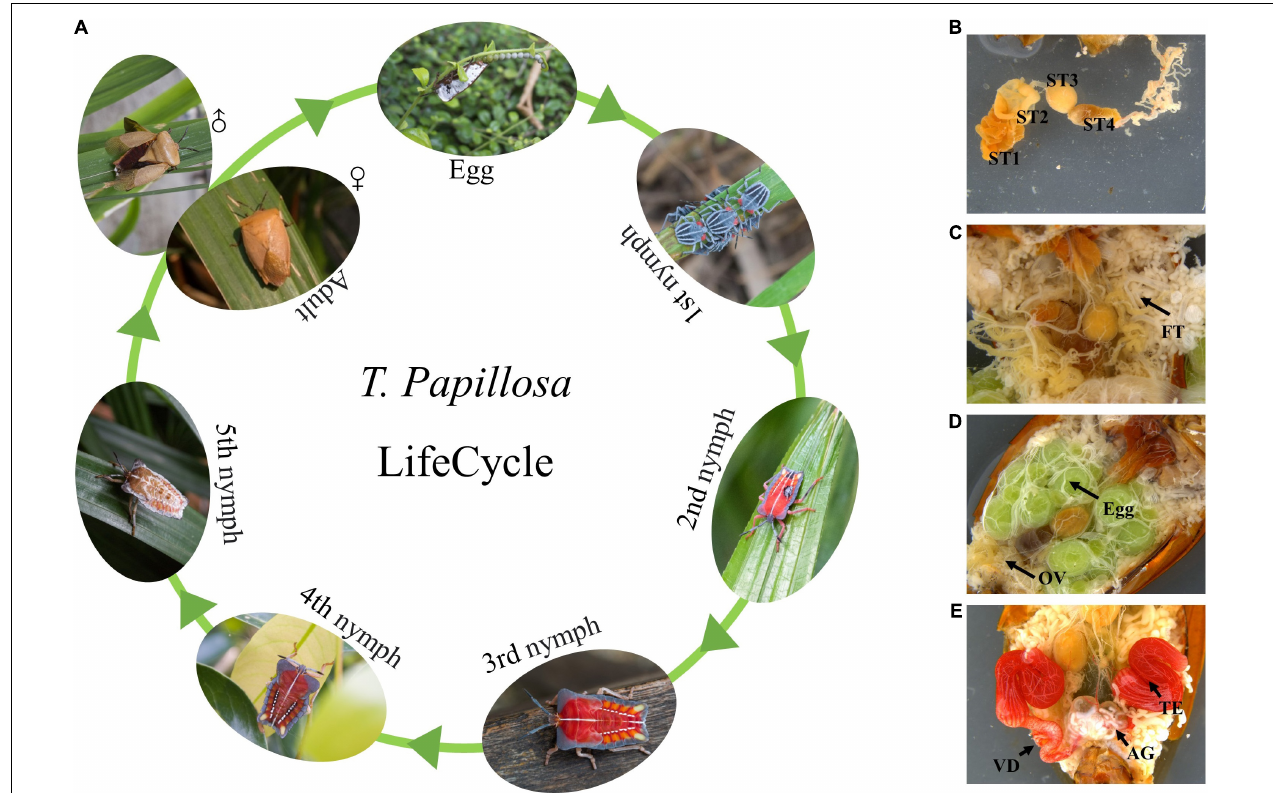
FIGURE 1 | Morphology of T. papillosa at different developmental stages and organization Chart. (A) T. papillosa Life cycle. (B) reproductive system of female adult. (C) Digestive tract. (D) Internal organs. (E) reproductive system of male